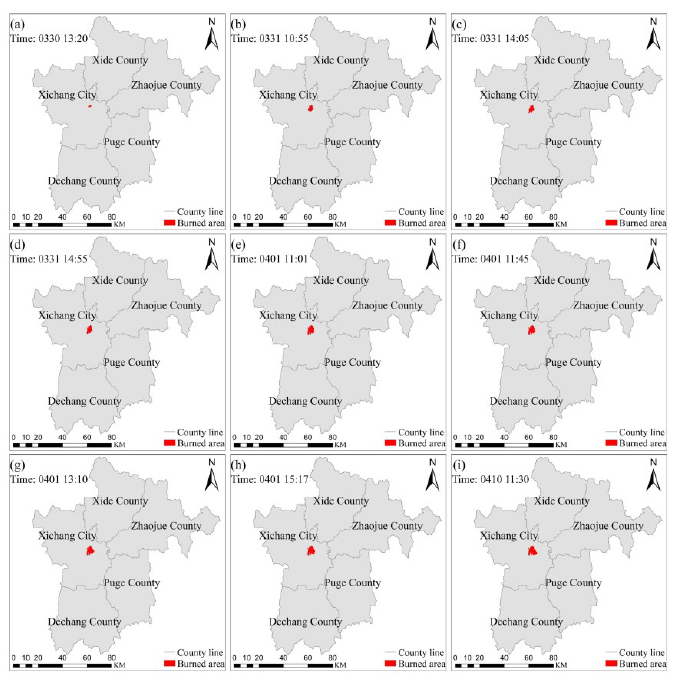
Figure 6. Multi-source satellite remote sensing image extraction of the burned area in Jingjiu Town- ship. ( a ) at 13:20 p.m. on 30 March, ( b ) at 10:55 a.m. on 31 March, ( c ) at 14:05 p.m. on 31 March, ( d ) at 14:55 p.m. on 31 March, ( e ) at 11:01 a.m. on 1 April, ( f ) at 11:45 a.m. on 1 April, ( g ) at 13:10 p.m. on 1 April, ( h ) at 15:17 p.m. on 1 April, ( i ) at 11:30 a.m. on 10 April in